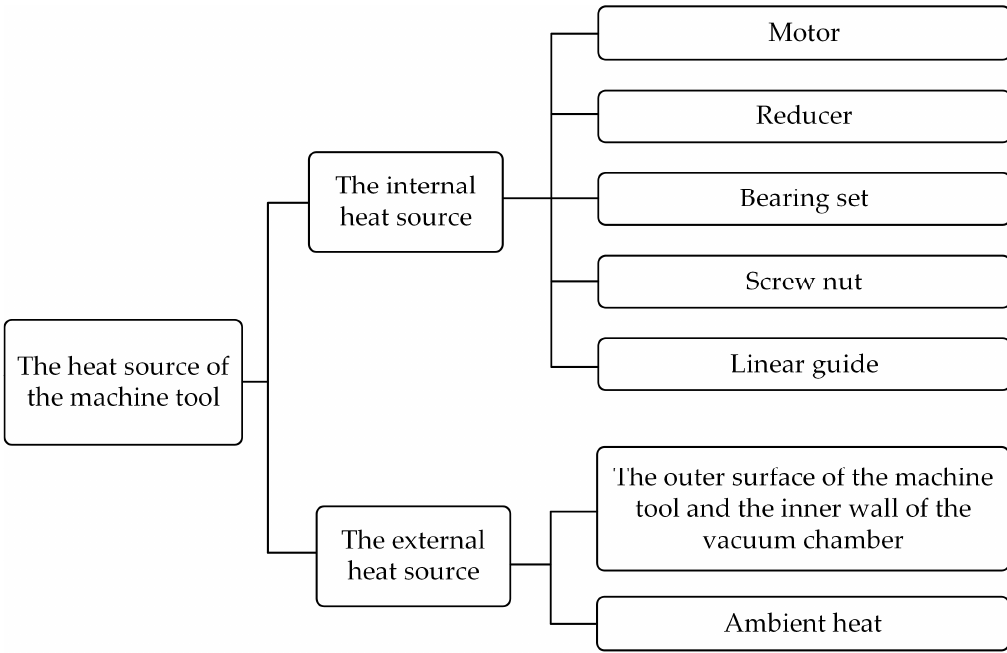
Figure 4. Heat source diagram of the whole machine.